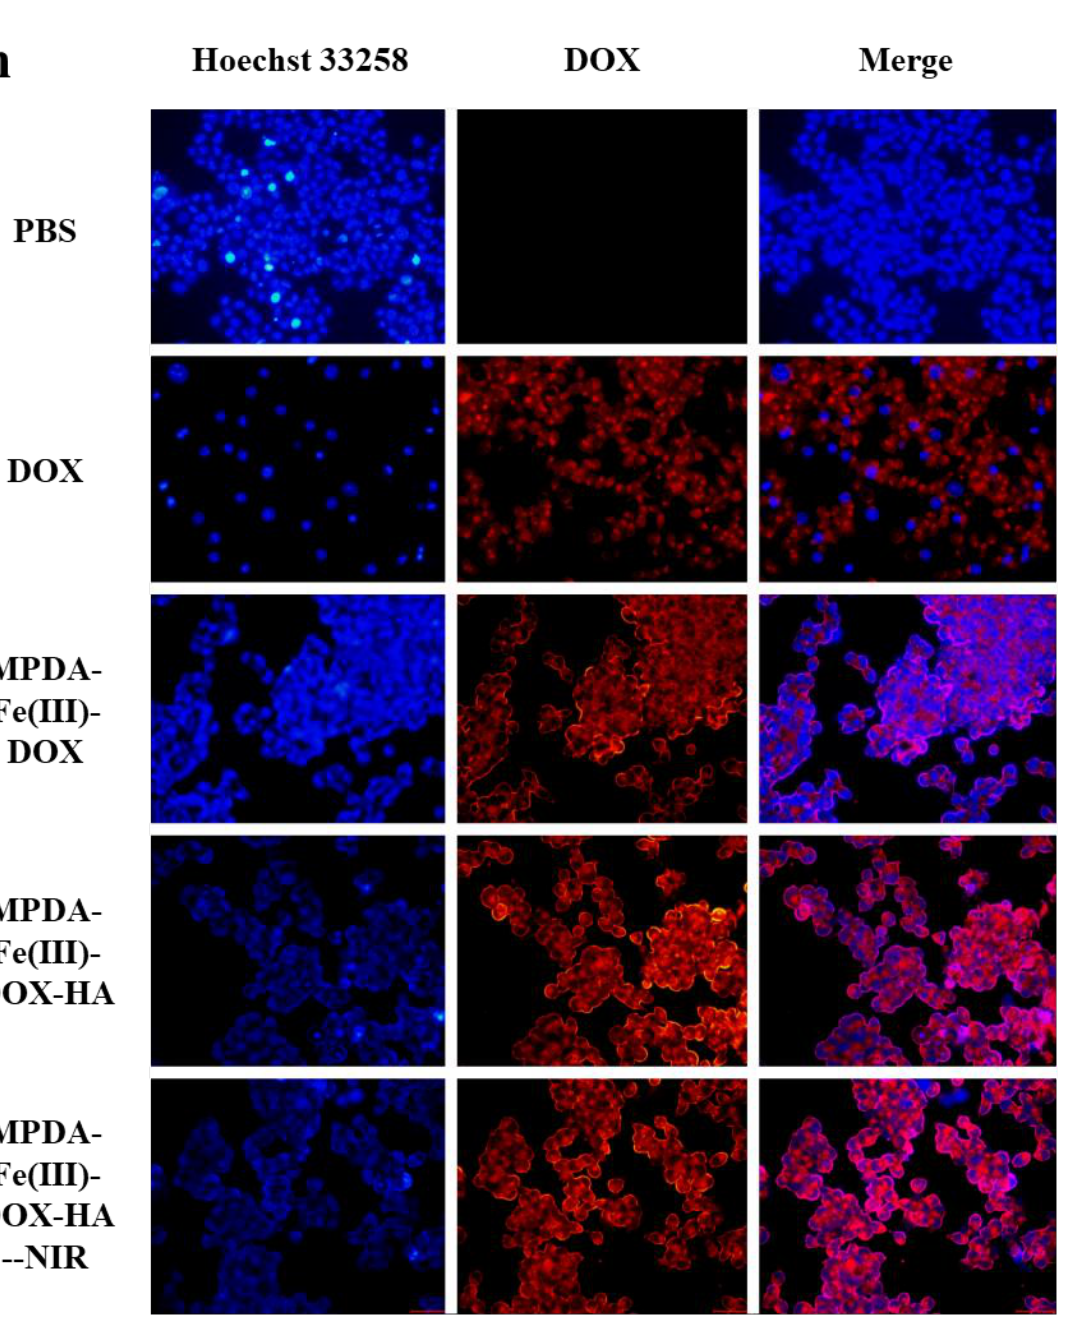
Figure 10. The cell survival and uptake capacity of the free DOX, MPDA-Fe(III)-DOX, MPDA-Fe(III)-DOX-HA, and MPDA-Fe(III)-DOX-HA-NIR groups cultured in HCT-116 cells for 4 h and 8 h at the same DOX concentration.